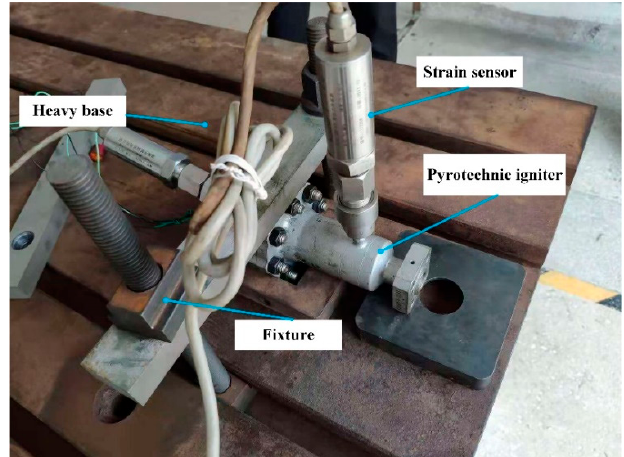
Figure 4. Configuration of the experiment.